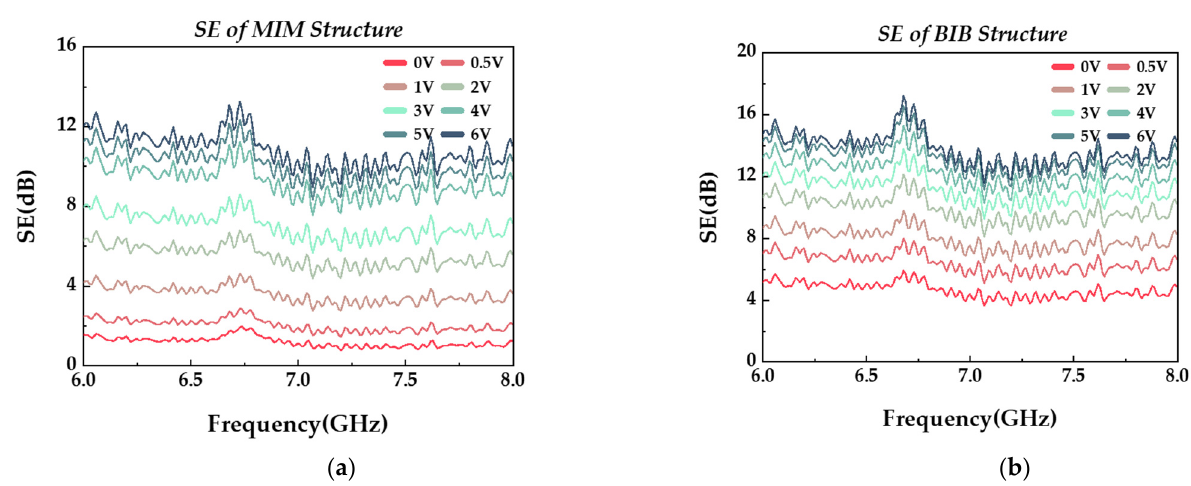
Figure 6. Shielding effectiveness of the ( a ) MIM and ( b ) BIB structure with different voltages.